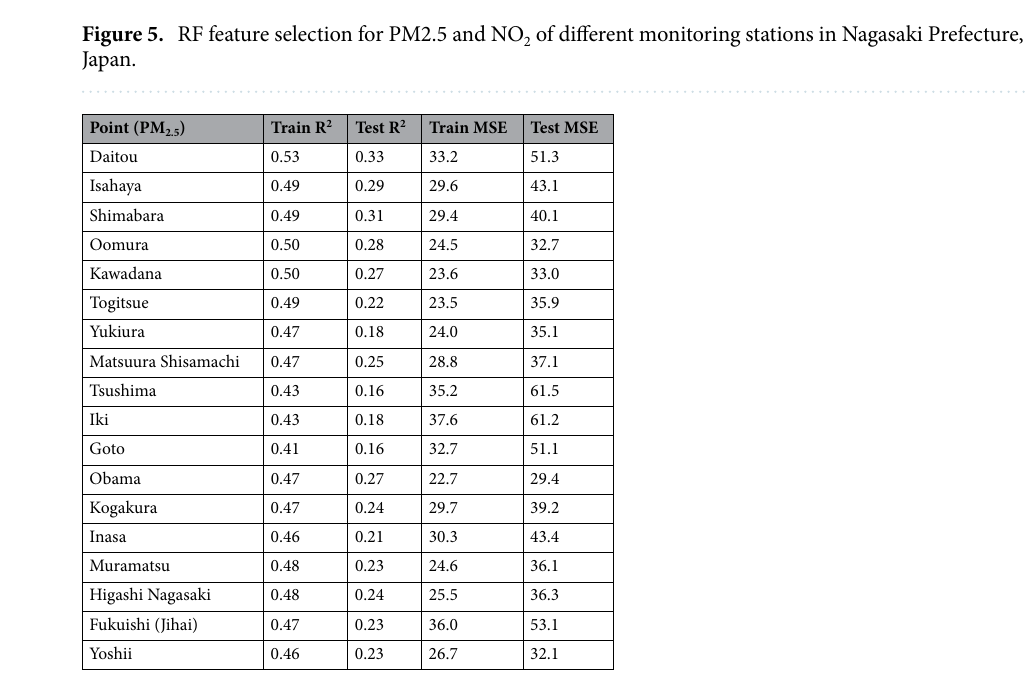
Table 3. Result of the random forest model for PM 2.5 using hyperparameters of the optimum value.